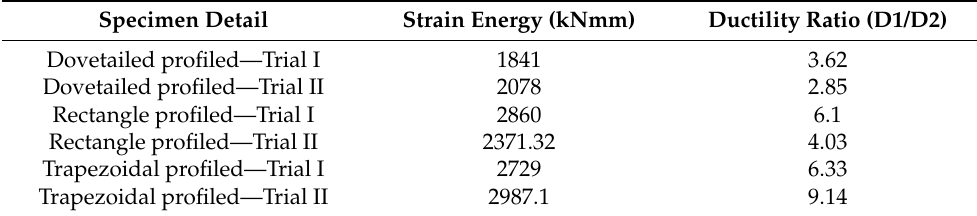
Table 5. Strain energy and ductility ratio for three types of profiled